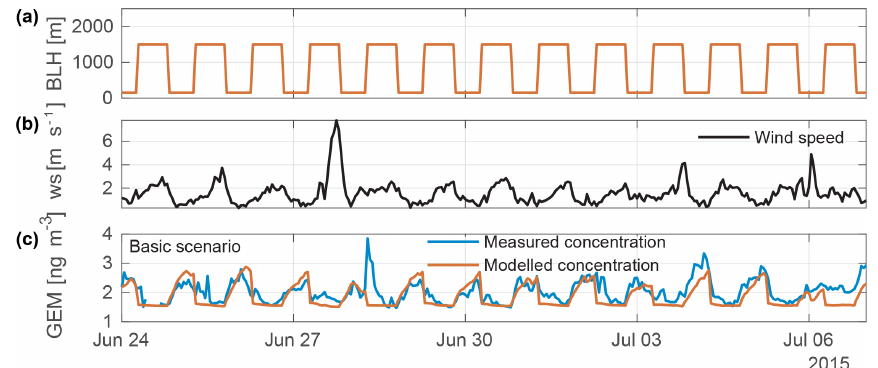
Figure 3. Example period from 24 June until 6 July 2015 that shows a day–night pattern for ground inversion. (a) shows the boundary-layer heights for the basic scenario (orange). (b) shows the wind speed (ws). (c) shows GEM measurements in blue and the basic model results in orange.